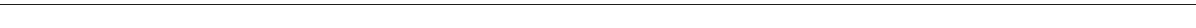
Fig. 3 Mapping the interacting domains in host Caspr1 and E. coli IbeA. a Schematic representation of the domain structure of full-length Caspr1 and its truncated forms. The coordinates of prey clones were labeled as yellow line. b Truncated forms of Caspr1 with His-tag were subjected to in vitro transcription and translation, and then co-incubated with the beads prebound with GST-IbeA, with GST as control, for GST pulldown assay. Precipitates were analyzed with anti-His antibody. Asterisk represents precipitated Caspr1(203 – 538). Images are representative of three independent experiments. Full blots are shown in Supplementary Fig. 8. c HEK293T cells were transiently transfected with truncated forms of Caspr1 with His-tag. The cell lysate were prepared and co-incubated with the beads prebound with GST-IbeA, with GST as control, for GST pulldown assay. Asterisk represents precipitated Caspr1 (203 – 538). Images are representative of three independent experiments. Full blots are shown in Supplementary Fig. 8. d The 203 – 355 and 356 – 538 domain of Caspr1 with His-tag were in vitro translated and then co-incubated with the beads prebound with GST-IbeA, with GST as control, for GST pulldown assay. Asterisk represents precipitated Caspr1(203 – 355) and rhombus represents the input proteins. Images are representative of three independent experiments. Full blots are shown in Supplementary Fig. 8. e HBMECs were stably transfected with Caspr1 mutant with deletion of aa 203 – 355 (Caspr1 Δ 203 – 355) identi fi ed by western blot, with empty vector as control. Full blots are shown in Supplementary Fig. 8. Then HBMECs were subjected to bacterial adhesion (top panel) and invasion (bottom panel) assays. Values are mean ± SD, n = 3. *** P < 0.001, one-way ANOVA. f Schematic illustration of the full-length IbeA protein and the truncated forms of IbeA tagged with GST. g In vitro translated His-tagged Caspr1(203 – 355) protein was subjected to GST pulldown in the presence of truncated forms of IbeA containing GST-tag, with GST as a control. Then the precipitates were analyzed by western blot with anti-His antibody. Asterisks represent the truncated forms of IbeA protein. Images are representative of three independent experiments. Full blots are shown in Supplementary Fig. 8. h Identi fi cation of E. coli mutant strain with deletion of ibeA(229 – 342) (E44-IbeA Δ 229 – 342) by PCR ampli fi cation. The parent strain E44 served as a control. Images are representative of three independent experiments. i Bacterial adhesion (upper panel) and invasion (lower panel) assays were performed using E44 strain, ibeA deletion mutant strain ZD1 and E44-IbeA Δ 229 – 342. Values are means ± SD, n = 3. ** P < 0.01, one- way ANOVA. j Bacterial invasion assays were performed with ZD1 strain transformed with constructs encoding full-length IbeA or IbeA Δ 229 – 342. E44 transformed with empty vector served as control. Values are means ± SD, n = 3. ** P < 0.01, one-way